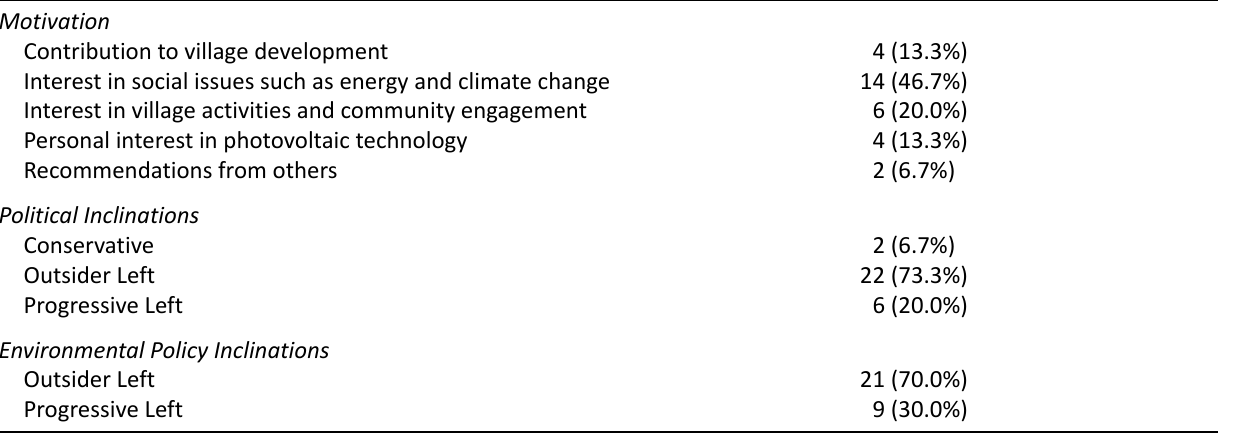
Table 2. (Cont.) Descriptive statistics.